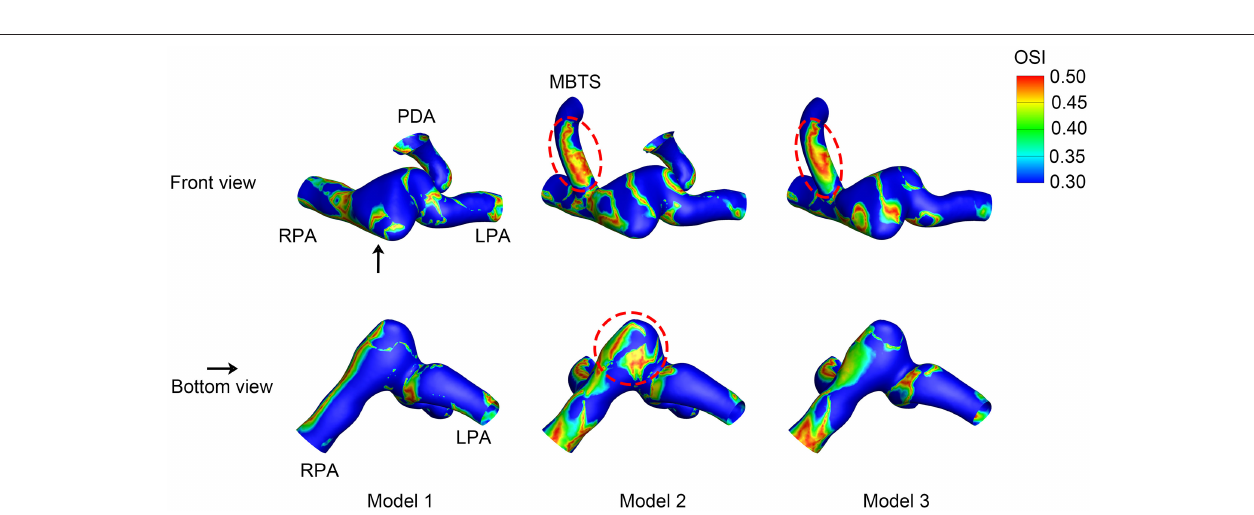
FIGURE 6 | Oscillatory shear index (OSI). The upper row is the front view, and the lower row is the bottom view of each model except for the aorta. The black arrow indicates the perspective of the bottom view. PDA, patent ductus arteriosus; MBTS, modified Blalock-Taussig shunt; LPA, left pulmonary artery; RPA, right pulmonary